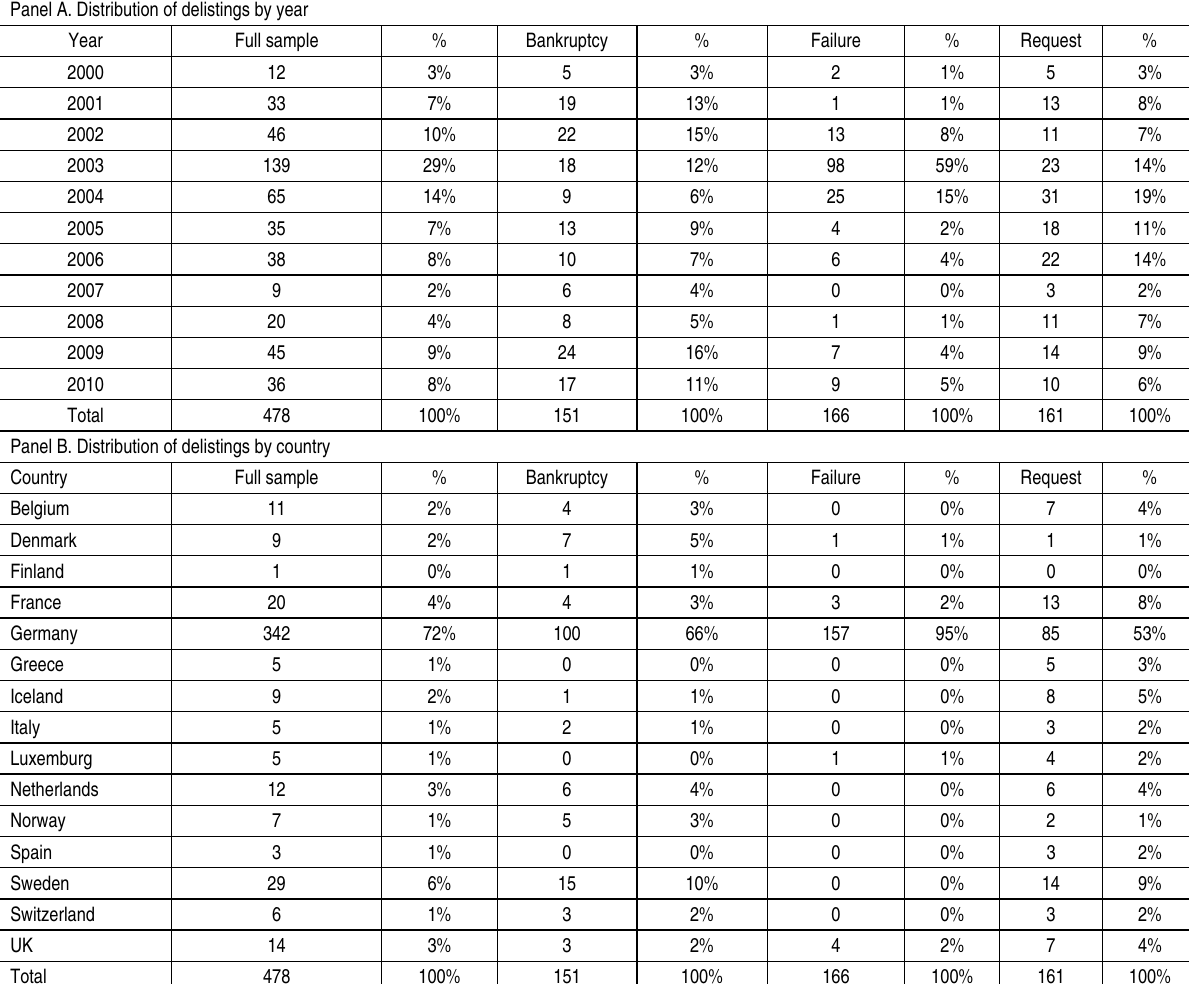
Table 1. Distribution of delistings per year and type Panel A. Distribution of delistings by year